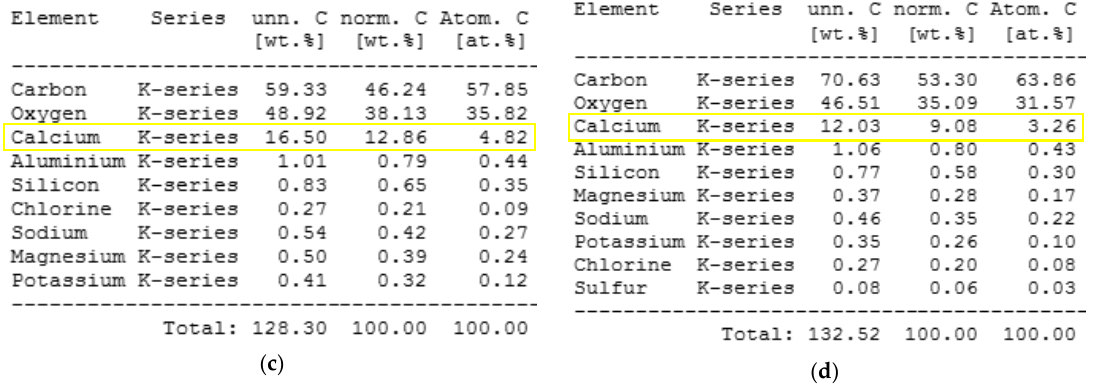
Figure 10. EDS surface analysis of ( a ) reference (I), ( b ) distilled water (IV), ( c ) alkalis at 60 (VI), ( d ) sea water (VII). The changes of calcium content on the surface have been marked with yellow boxes—decreasing values suggest elution of mineral fillers.